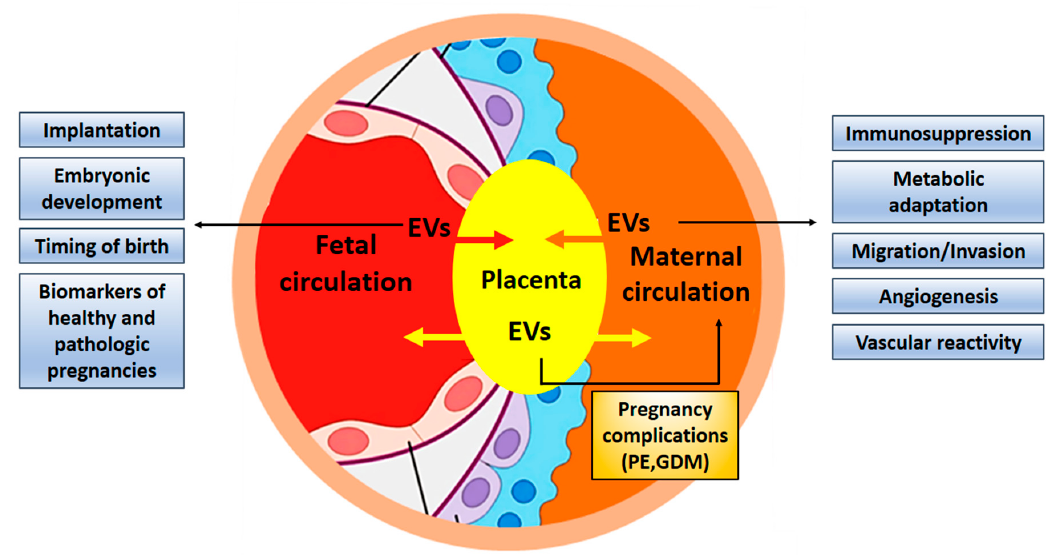
Figure 3. Exosomes contribute to fetal-maternal communication. Exosomes are exchanged between maternal and embryonic tissues to facilitate implantation and development of the embryo, adapting the maternal organism for pregnancy by suppressing immune responses and guaranteeing nutritional supply. Exosomes can also contribute to pregnancy complications and might be used as biomarkers.